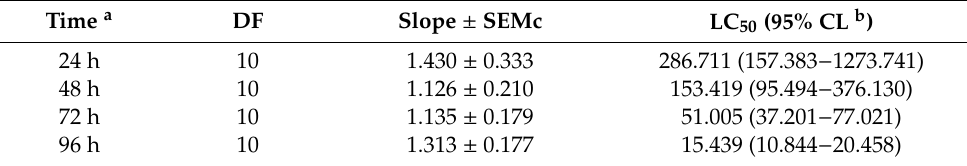
Table 4. Dose e ff ect of S. litorale CTP19-1 species on G. mellonella .